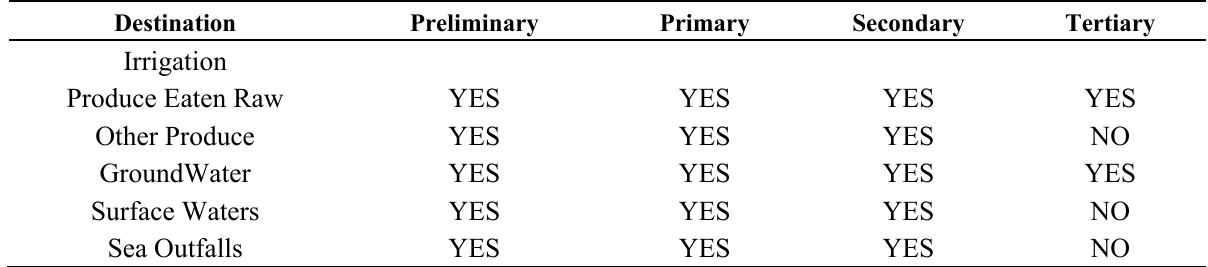
Table 2. Overview of treatment requirements for selected effluent